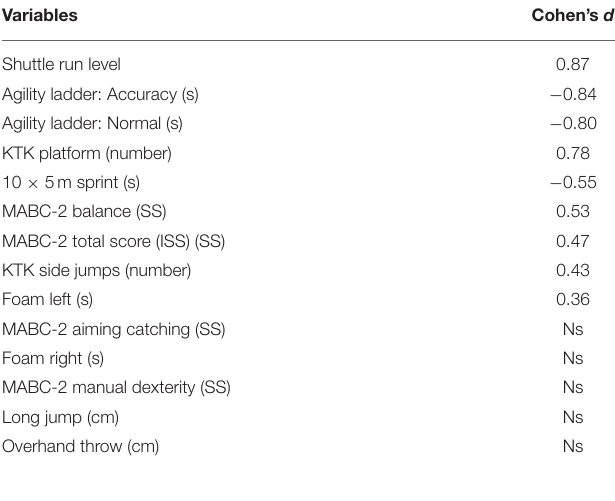
TABLE 5 | Effect sizes for the changes in motor and fitness performance variables.